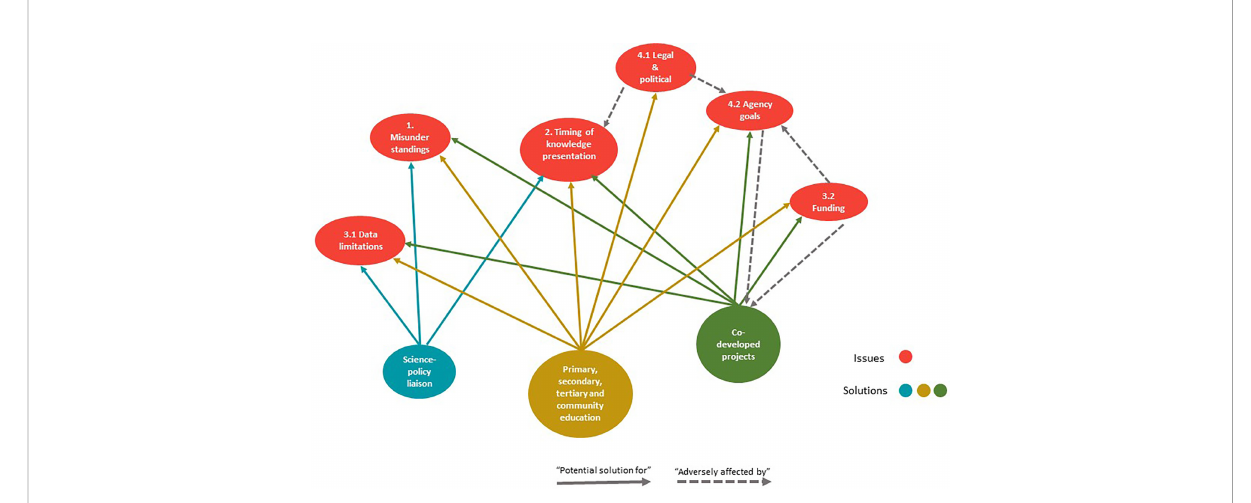
FIGURE 2 Summary of issues and presently used and suggested solutions for Aotearoa-New Zealand. Issues are labelled as they occur in the text. Solutions for the issues are tracked to each issue and colour coded by the solution. Issues are numbered as they are presented in the text, although without the preceding section 2 number. Solutions and issues that are adversely affected by issues are connected by a dashed